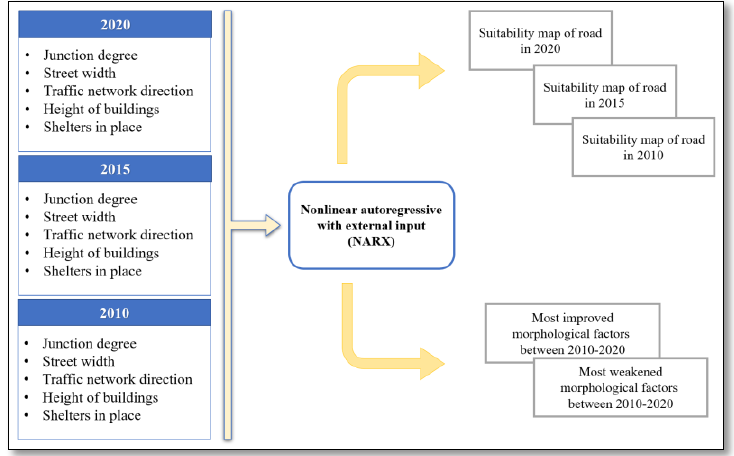
Figure 1. The procedure of the proposed